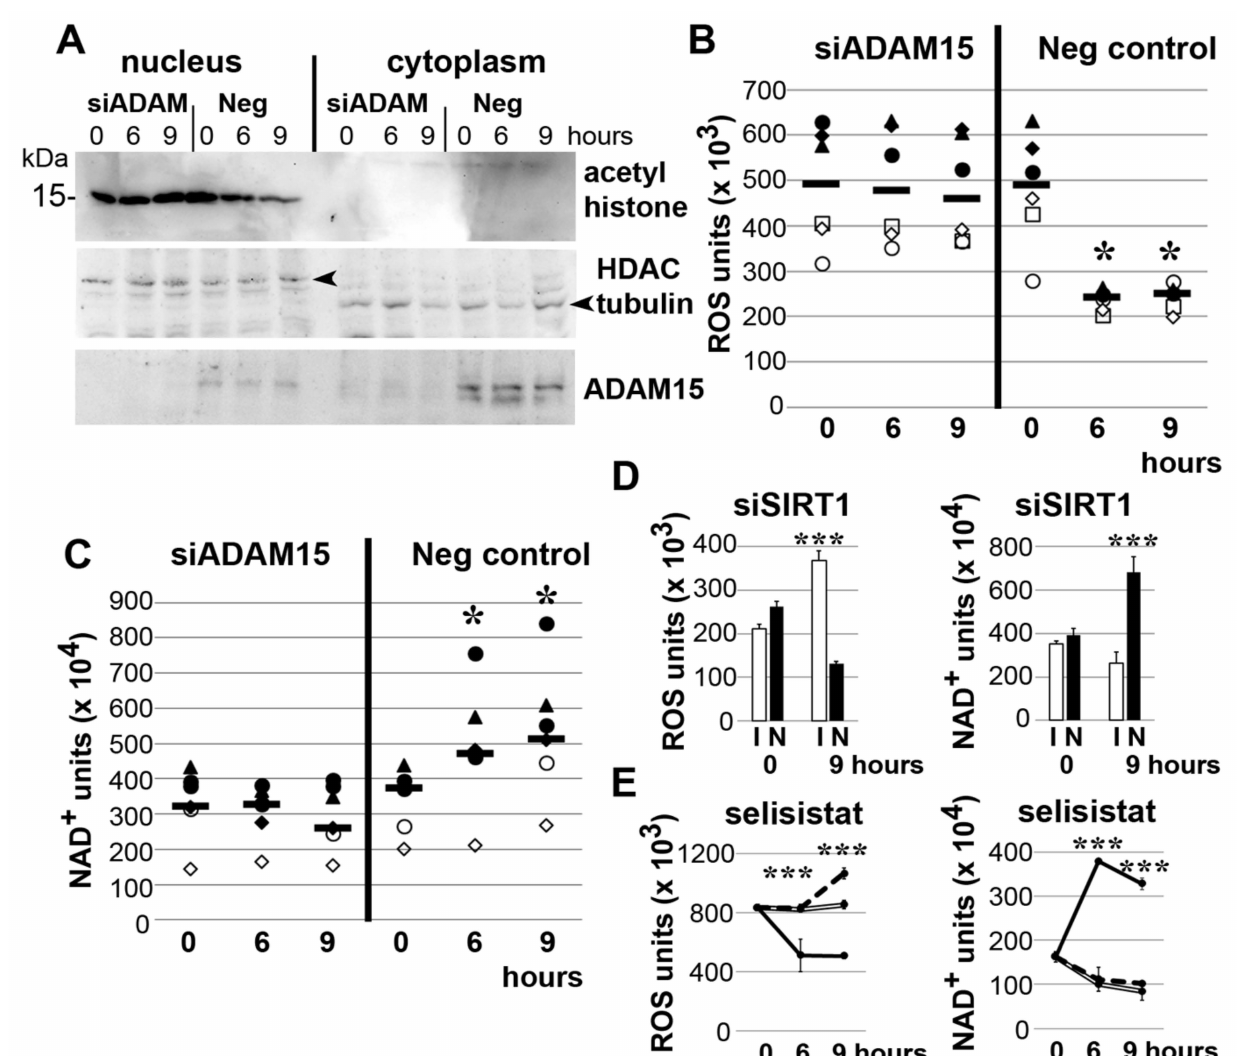
Figure 3. Impact of ADAM15 and SIRT1 on histone acetylation, ROS and NAD+ in mechanically strained SF. ( A–C ) ADAM15 was downregulated by siRNA and a non-silencing siRNA (neg) as control. ( A ) Immunoblots from nuclear and cytoplasmic lysates of SF, showing decreased deacetylated histone after 6 and 9 h strain in ADAM15-expressing cells only. Tubulin and histone deacetylase (HDAC1) served as loading controls. ( B,C ) ROS and NAD+ assays in ADAM15-expressing SF (neg control) as compared to ADAM15-silenced cells. Each symbol represents the mean value of one individual donor, the horizontal bar (-) the median of 6 different donors. * p < 0.05, by Wilcoxon signed-rank test for comparison of ADAM15- expressing versus non-expressing SF. ( D ) ROS and NAD+ assays from mechanically strained SF with prior downregulation of SIRT1 by siRNA (I) and a non-silencing siRNA (N) from one representative donor. *** p < 0.0005, by Student’s t -test for SIRT1-expressing versus non-expressing SF. ( E ) ROS and NAD+ assays from strained SF in the presence of SIRT1 inhibitor selisistat (0 µ M; solid line, 50 µ M; double line and 100 µ M; dashed line) from one representative donor. *** p < 0.0005, by Student’s t -test, comparing DMEM with the inhibitor. Representative results of at least three independent experiments are